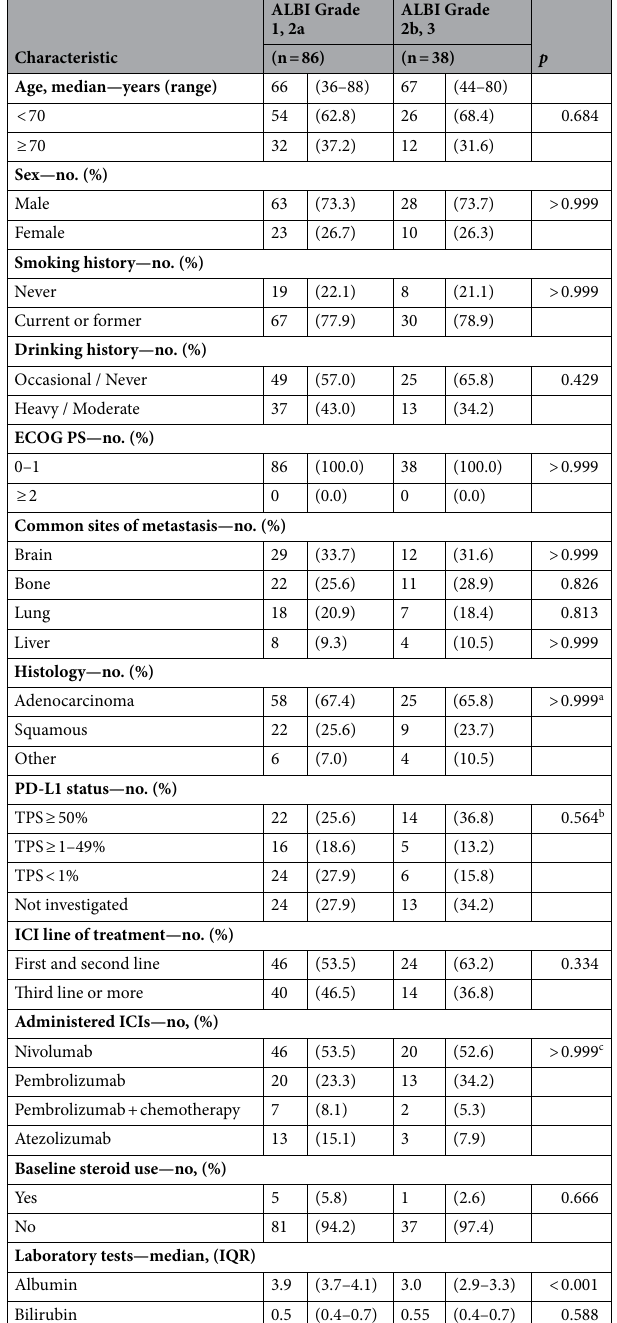
Table 3. Association between ALBI Grade and clinical variables in patients with PS 0–1. ALBI grade albumin– bilirubin grade, ECOG PS eastern cooperative oncology group performance status, PD-L1 programmed cell death ligand-1, ICI immune-checkpoint inhibitor, TPS tumor proportion score, IQR interquartile range. a Adenocarcinoma versus all others, b PD-L1 TPS ≥ 1% versus all others, c Administered immune checkpoint inhibitors, nivolumab versus all